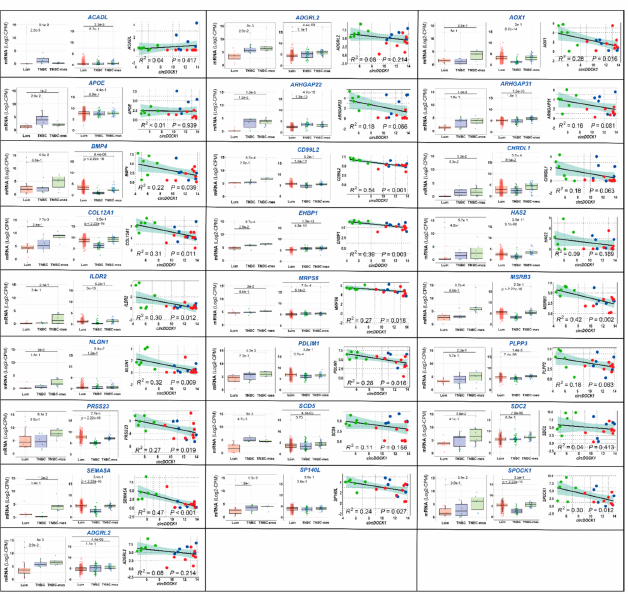
Figure 5. The expression profiles of some of the circDOCK1-1 downregulated genes in breast cancer cell lines and tumour specimens. The indicated mRNAs are encoded by some of the genes that are commonly downregulated in MDA-MB-231 and MDA-MB-157 cells overexpressing circDOCK1-1 , according to our RNA-seq data. These mRNAs are characterized by a trend towards lower expression levels in the Lum vs. TNBC-mes cell lines belonging to our panel of 18 cell lines (left diagrams of each panel; the p -values of the indicated comparisons are shown, Wilcoxon test). The expression profiles of the mRNAs that can be determined from the RNA-seq data obtained from the breast cancer specimens available in the TCGA database are also illustrated (middle diagrams of each panel; the p -values of the indicated comparisons are shown, Wilcoxon test). The right diagrams of each panel show the quantitative correlations between the levels of the indicated mRNA and circDOCK1-1 in each breast cancer cell line considered. TNBC-mes , TNBC , and Lum cell lines are indicated by the green, blue, and red dots, respectively. The calculated R 2 correlation value (Pearson method) and the correlation p -value are